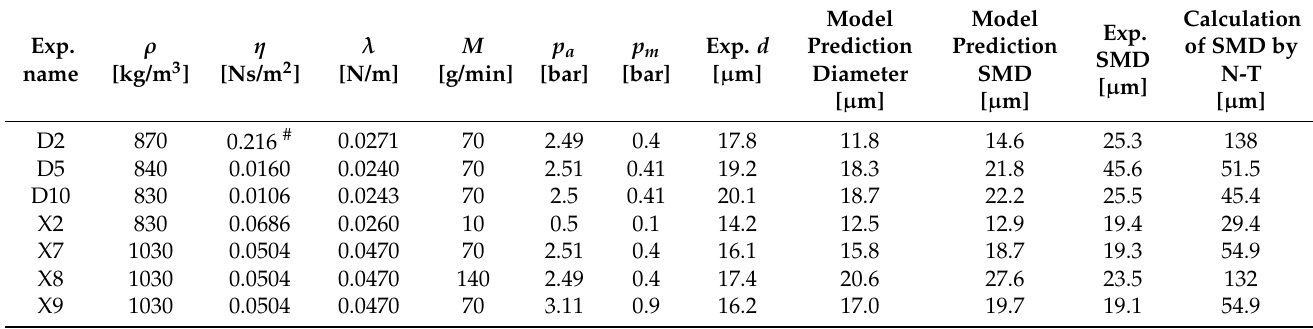
Table 5. Additional experiments performed for testing the semi-empirical model for average